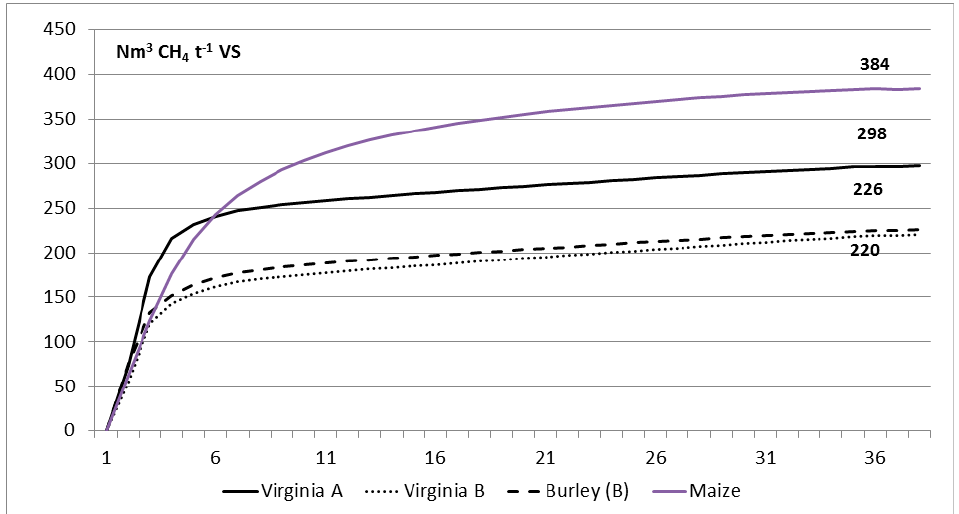
ff erent tobacco plantations and from Figure 2. Methane potential from different tobacco plantations and from maize. Figure 2. Methane potential from di